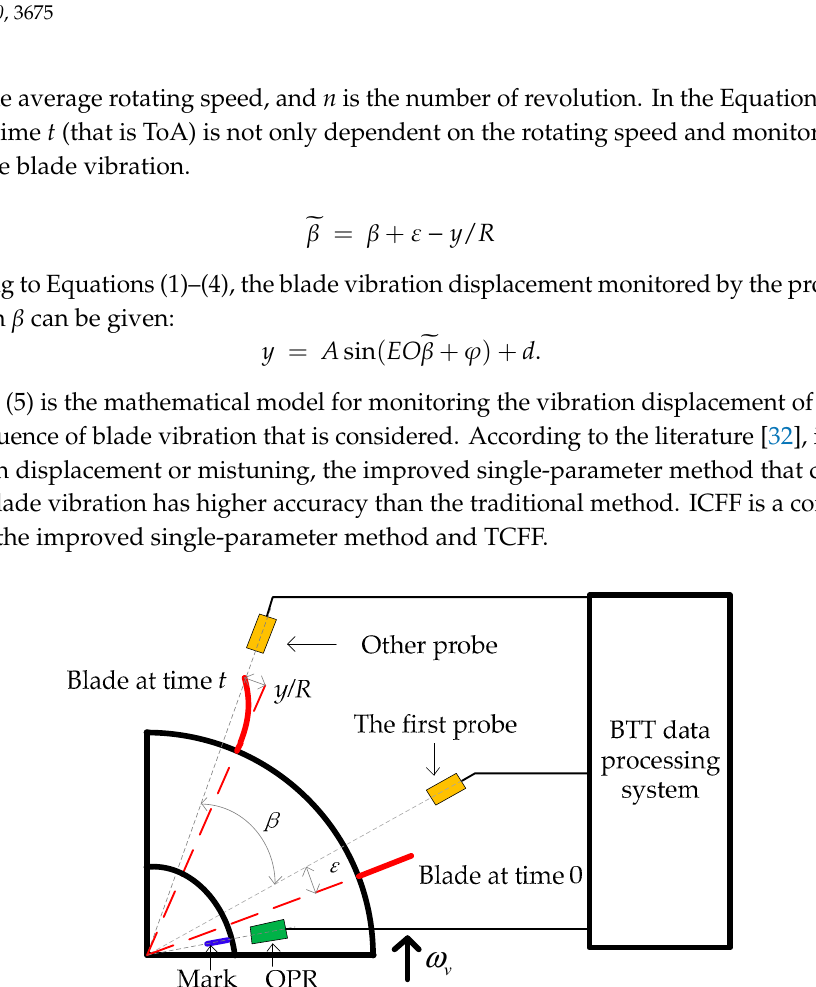
Figure 2. The schematic of the blade tip timing (BTT) measurement. The once per revolution (OPR) sensor monitors the rotating speed through the mark on the shaft and provides a timing reference for the BTT measurement system. The probe is responsible for monitoring the ToA. R represents the distance from the blade tip to the center of the rotor, and y / R represents the circumferential angle of the blade vibration. β represents the monitoring position, and ε represents the angle of the blade from the first probe when the mark passes the OPR sensor.